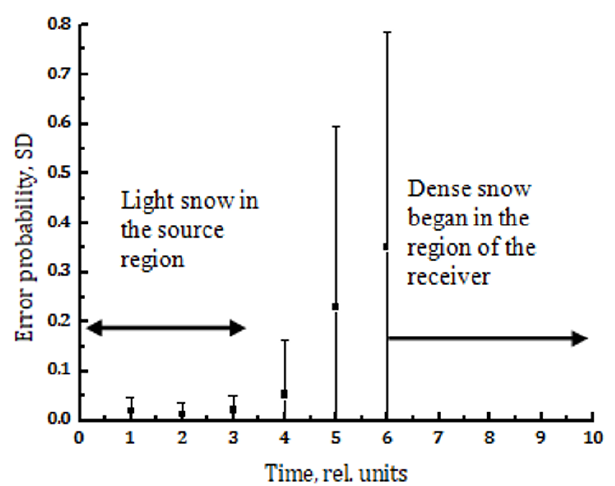
Figure 7. Results of investigation of the communication channel quality in the daytime; external weather conditions—continuous cloudiness.